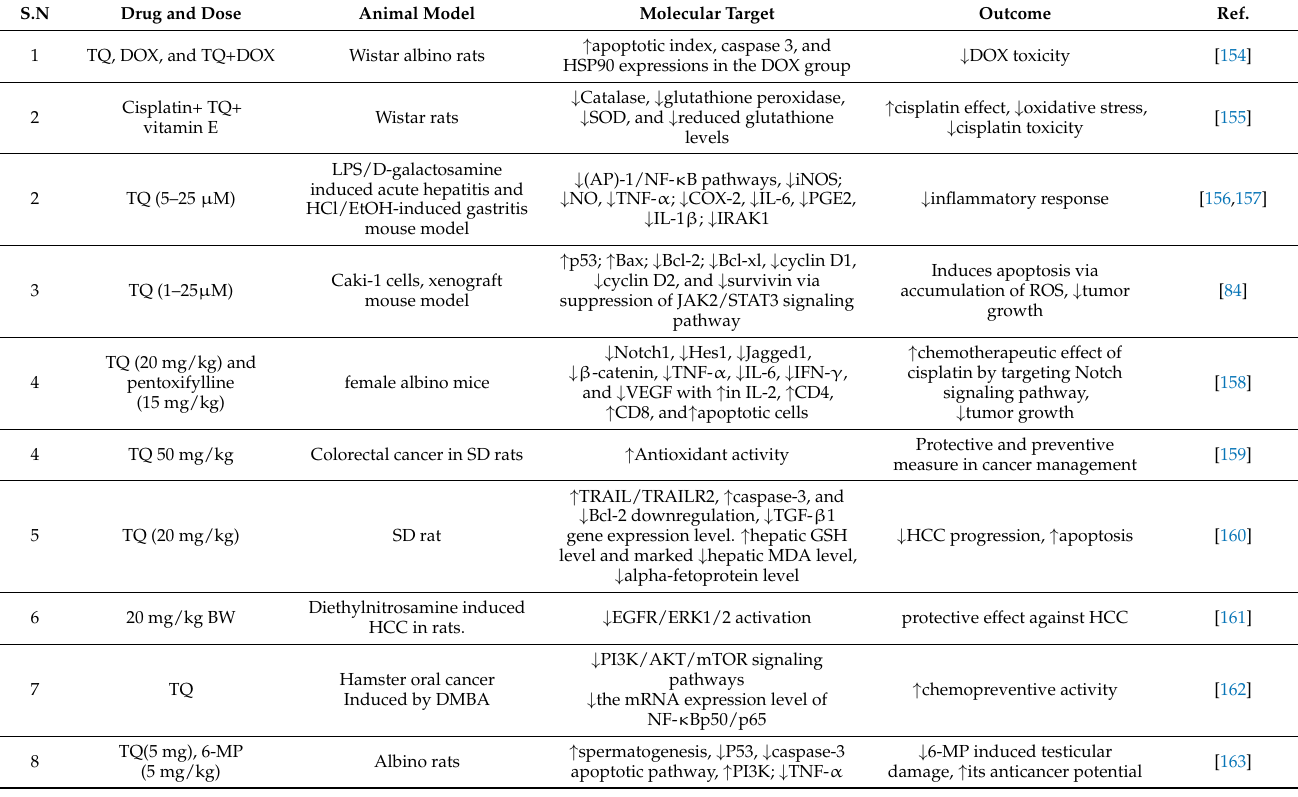
Table 4. In vivo applications of thymoquinone in the treatment of cancer ( ↓ : decrease, ↑ :